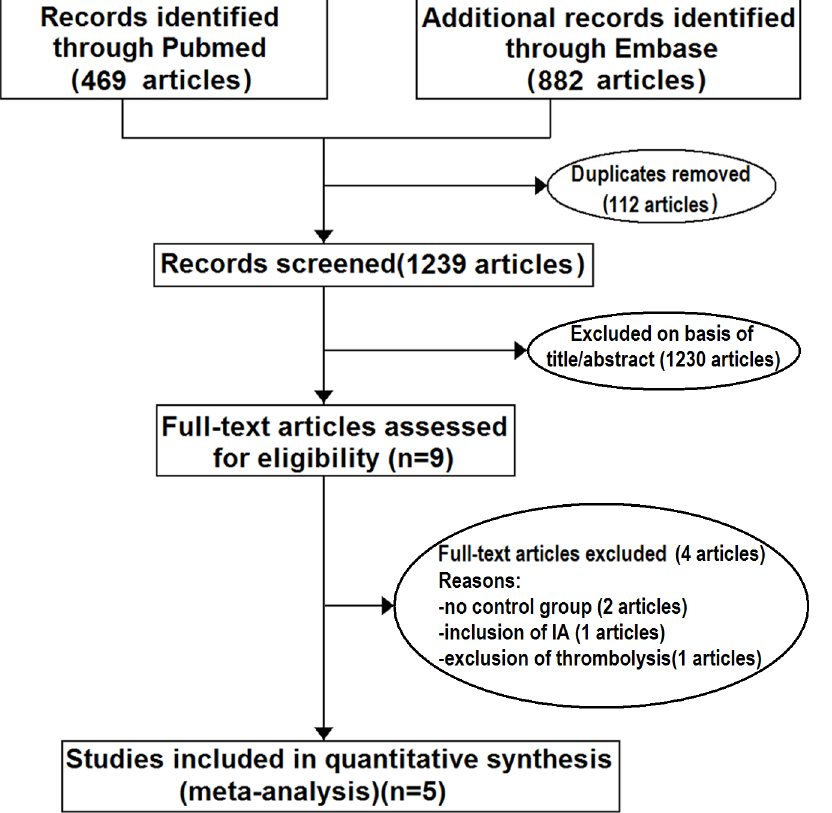
Fig 1. Flow chart of literature search and study